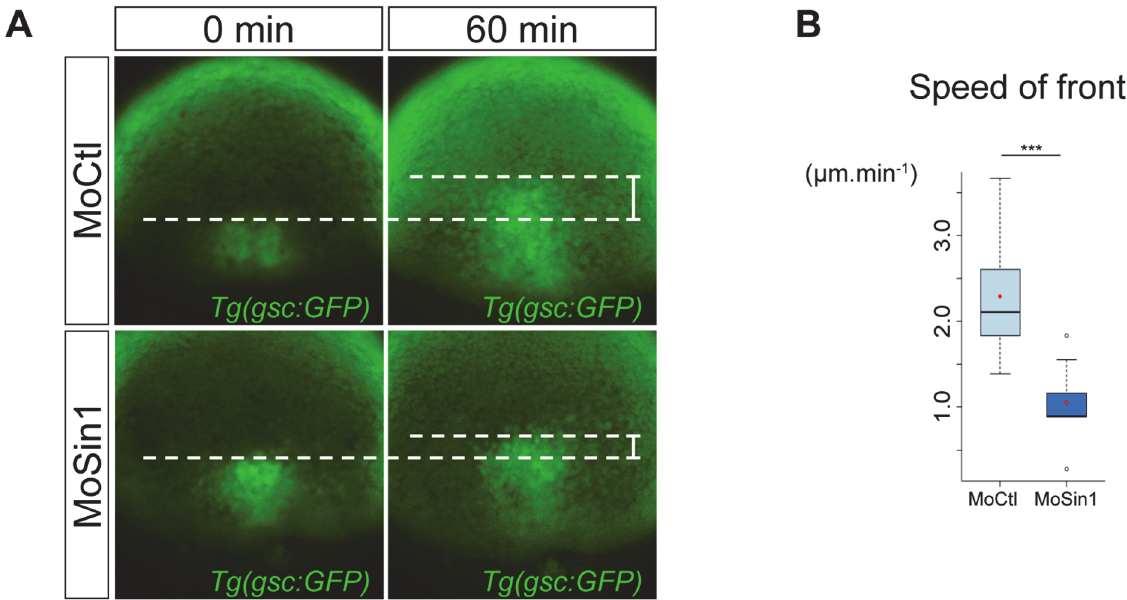
Fig 2. The prechordal plate migrates slower in sin1 loss of function. (A) Progression of the front of the prechordal plate was monitored in Tg(-1 . 8gsc : GFP) embryos (see S1 Movie). In embryos injected with the sin1 morpholino, the prechordal plate migrates twice slower than in embryos injected with a control morpholino. (B) Average speed of the front of the prechordal plate (distance travelled over one hour divided by 60 minutes), in embryos injected with a control morpholino or the sin1 morpholino.